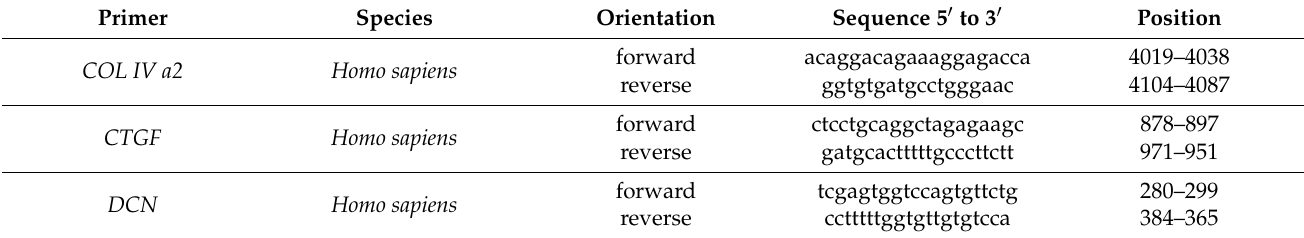
Table A1. Sequences and positions of primer pairs used for real-time